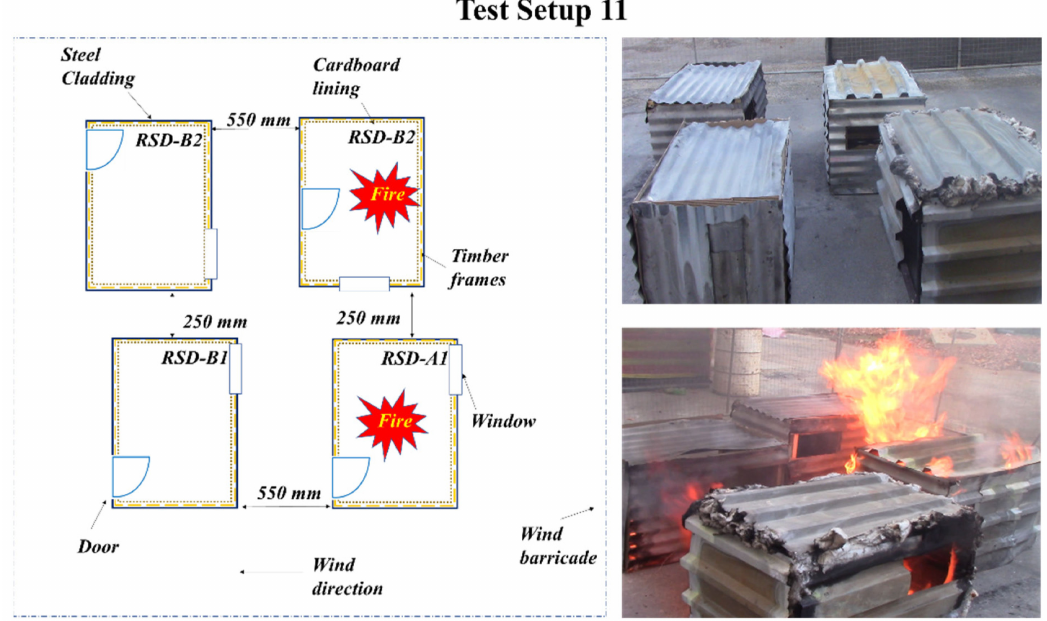
Figure 10. Four RSD experiment: test setup 12; clockwise—schematic view; test setup-12 @ 0 min; flame impingement from RSD-A2 at 11